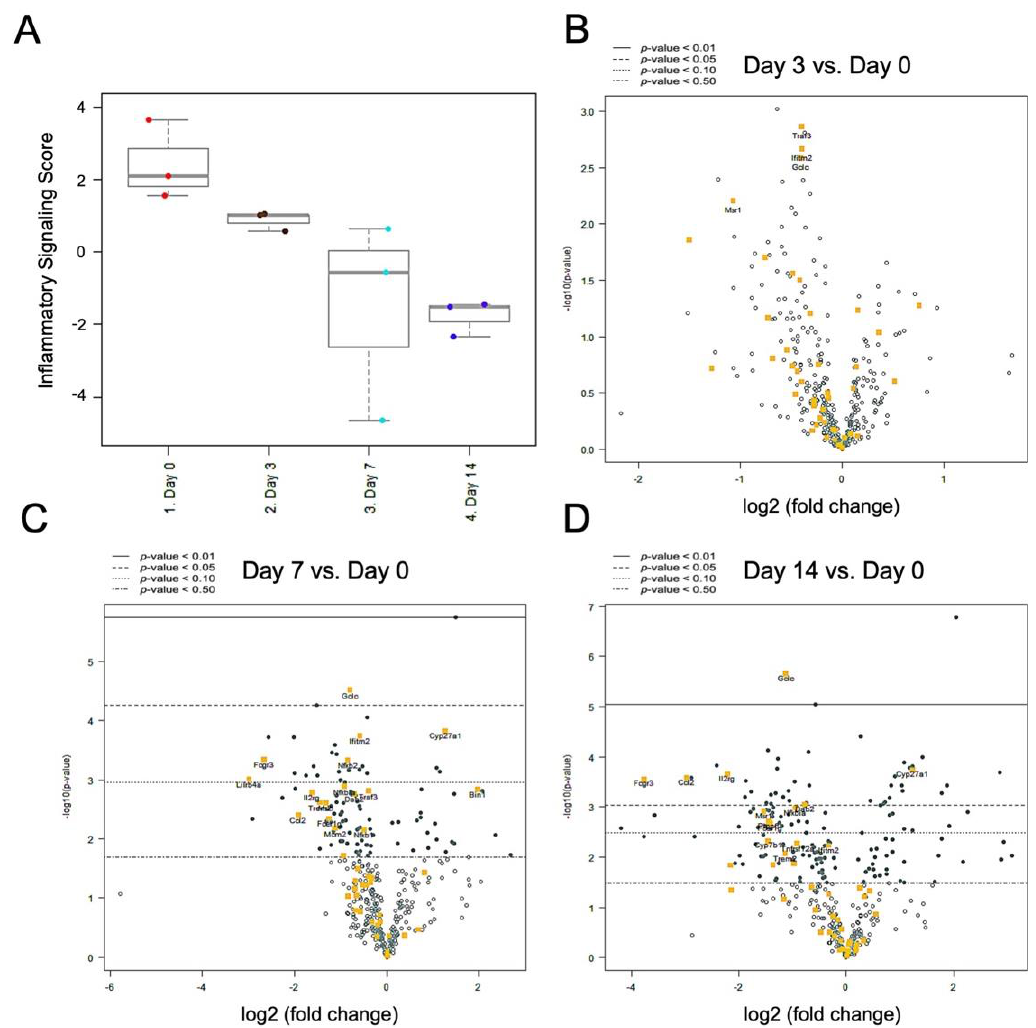
Figure 7. Differential gene expression in inflammatory signaling in injured nerve. ( A ) NanoString nCounter inflammatory signaling score revealed downregulation from day 0 to day 14. ( B – D ) Volcano plot of differential gene expression at day 3, day 7 and day 14, comparing with day 0. (n = 3 for each group).